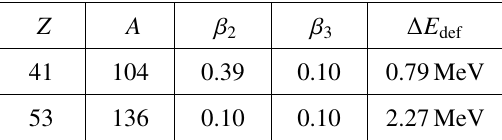
Table 2. Deformation parameters of the primary fragments and their extra deformation energy: